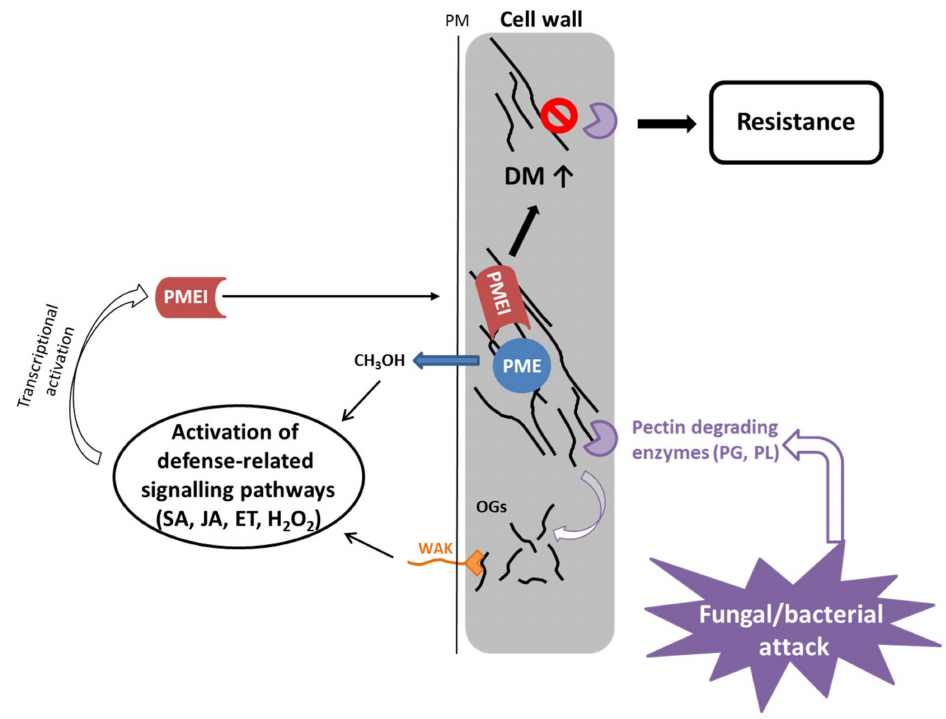
Figure 3. PMEIs modulate PME activity and DM of pectin in response to fungal and bacterial